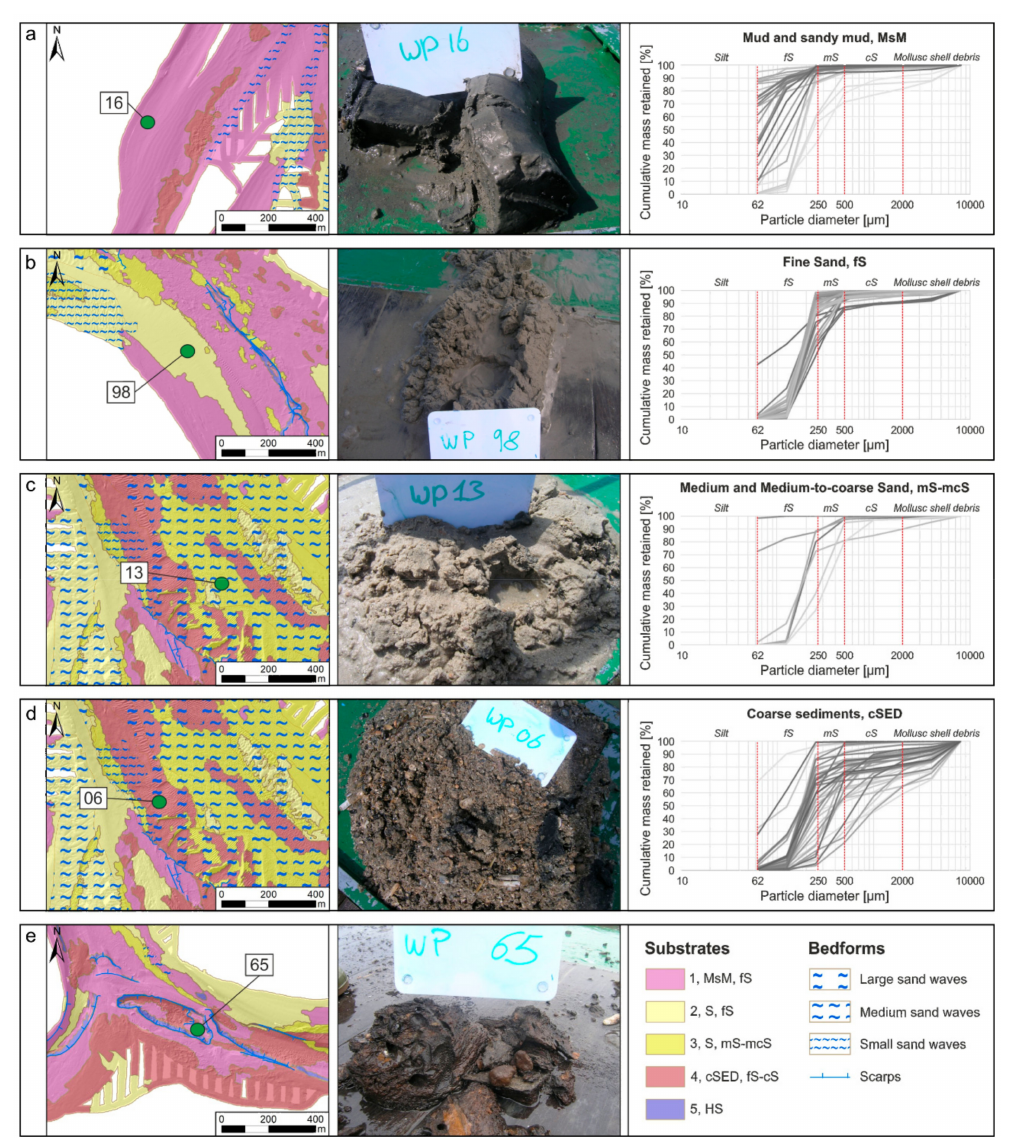
Figure 7. Lithological, geomorphological, and particle-size features of each classified cluster. The location is shown in Figure 3a. ( a ) Cluster 1 is characterized by mud and sandy mud, mainly including fine sand, and generally flat morphologies with absent or small sand waves. ( b ) Cluster 2 is mainly made of fine sand, with a flat to gently sloping morphology. It is locally covered by small to large sand waves. ( c ) Cluster 3 is characterized by heterogeneous sediment types, mainly made of medium to coarse sands, including samples of mud and sandy mud, fine sands, as well as coarse sediments. It is covered by small to large sand wave fields. ( d ) Cluster 4 is made of coarse sediments, including samples of mud and sandy mud, as well as fine sands. It presents small to large sand waves. ( e ) Cluster 5 is characterized by steep surfaces and breaks of slope, mainly related to hard substrates made of peat layers. Abbreviations in the legend refer to sample classes shown in Figure